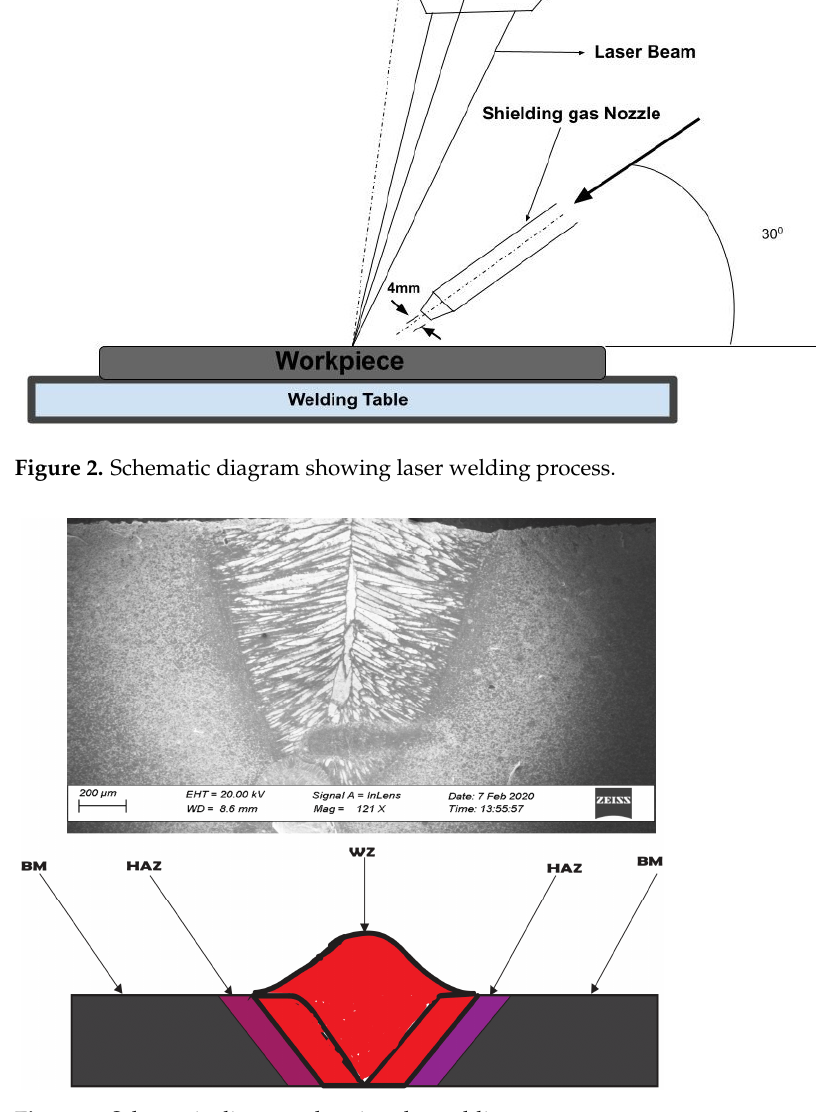
Figure 3. Schematic diagram showing the welding zones.